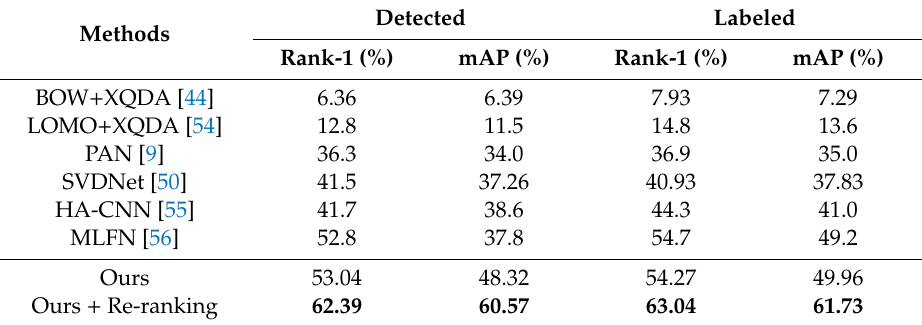
Table 7. Single query comparisons on the CUHK03